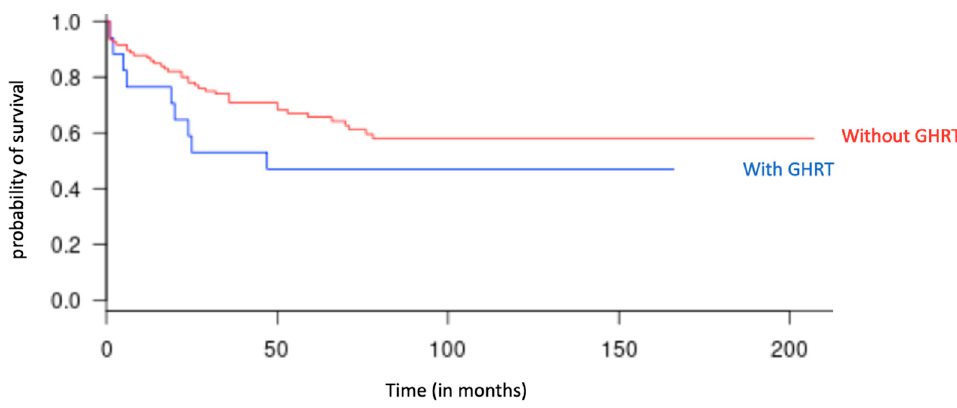
Figure 2. Relapse-free survival curve as a function of time (in months), in the groups with GHRT (in blue) and without GHRT (in red), over the entire duration of the study. Relapse was not significantly associated with age at diagnosis, gender, presence of NF1, or tumor type (Table 4). All of the analyses concerning the risk factors for relapse